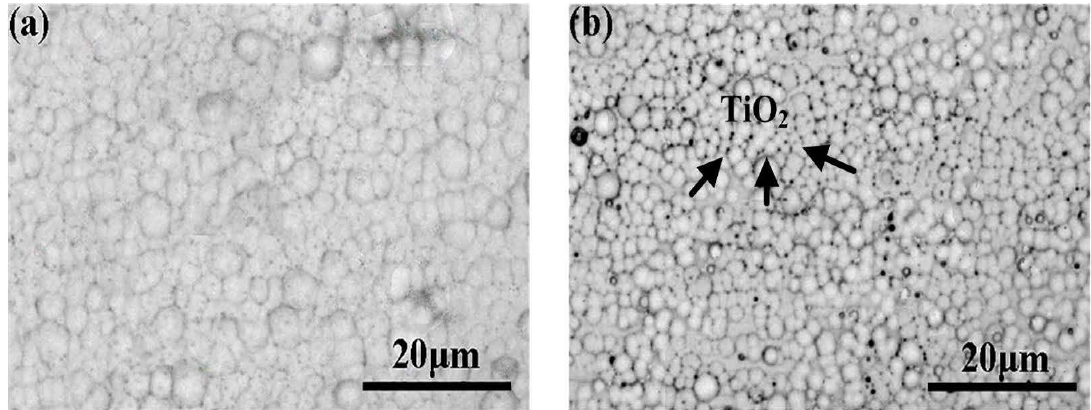
Figure 3. Surface morphology of duplex coatings: (a) duplex Ni-P/Ni-P coating, (b) duplex Ni-P-12.5mL/L TiO